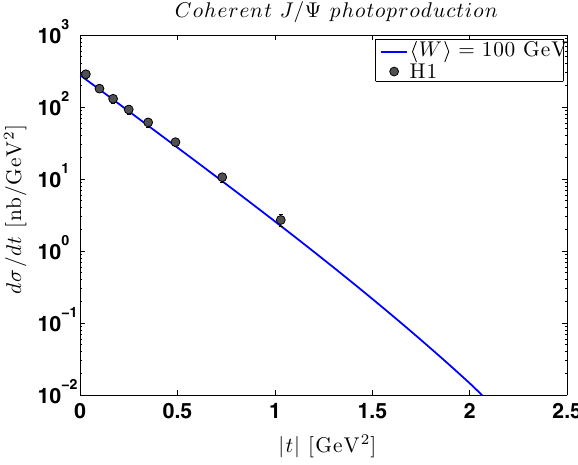
Fig. 1 Coherent photoproduction ( Q 2 = 0) cross section within the kinematical conditions of the HERA experiments: x IP ≈ 9 . 6 × 10 − 4 for (cid:4) W (cid:5) = 100 GeV. The parameter of Eq. (5) is chosen to be B G = 4 GeV − 2 . The H1 data are from